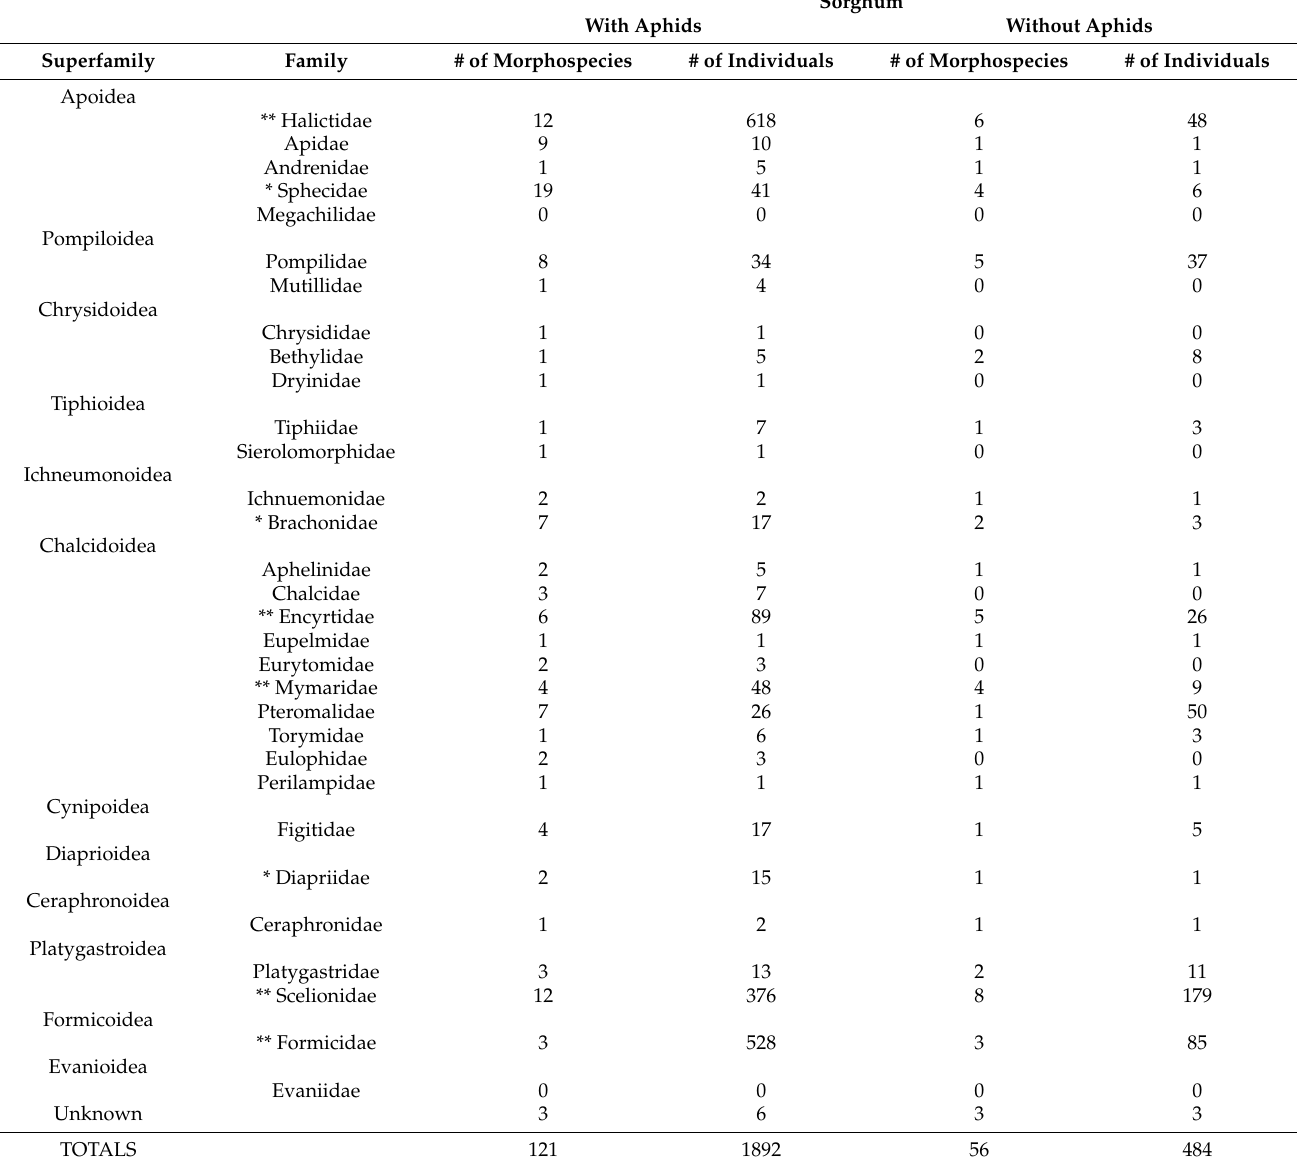
Table 2. Comparison of Hymenoptera families and morphospecies collected in sorghum with sorghum aphids and un-infested checks using pan traps and sticky